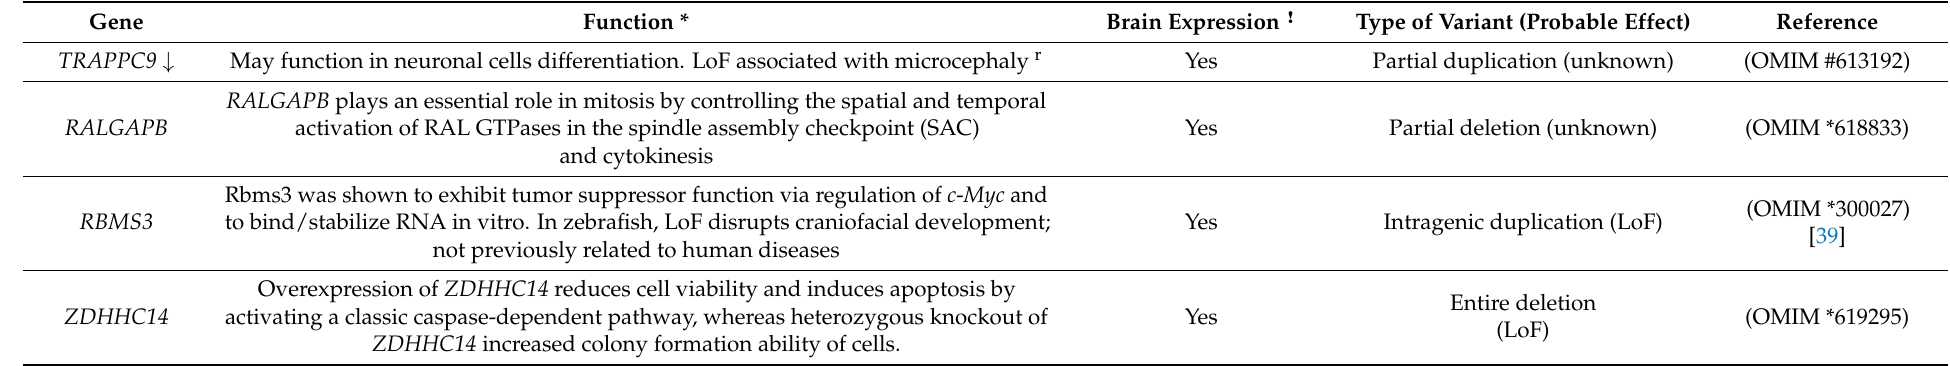
Table 2. Potential candidate genes for macrocephaly and their biological functions.